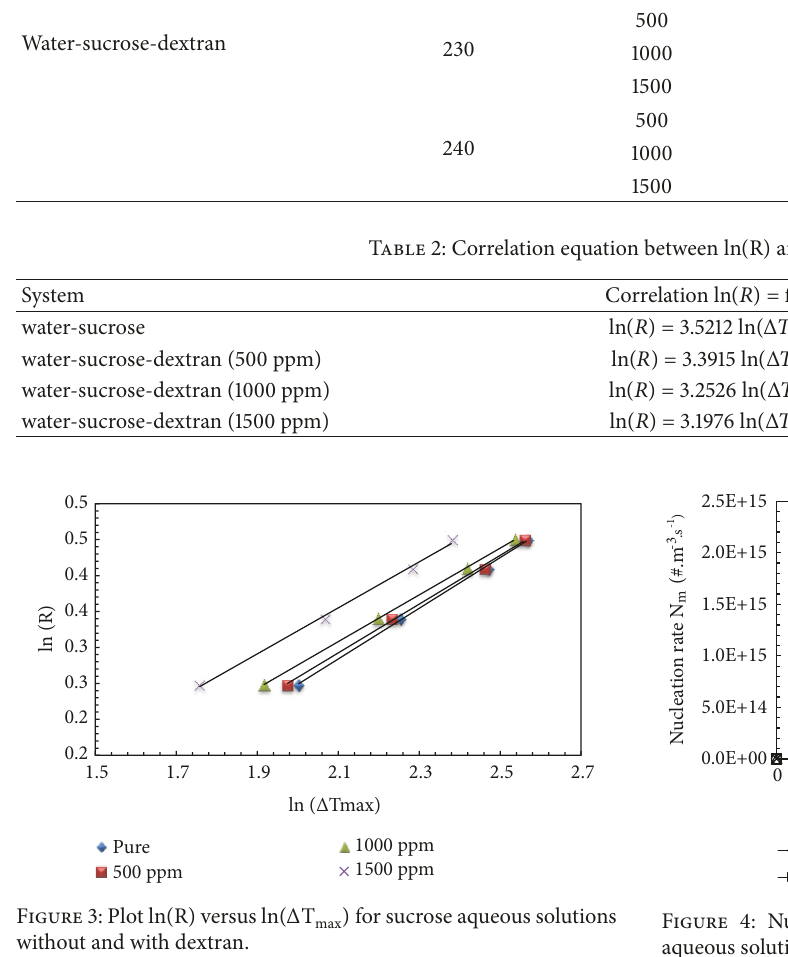
, crystallization temperature 𝑇 sat of dextran. im